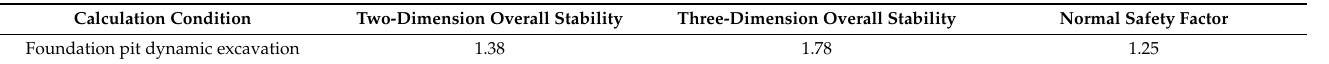
Table 6. Safety factor of slope stability on anchorage foundation pit.